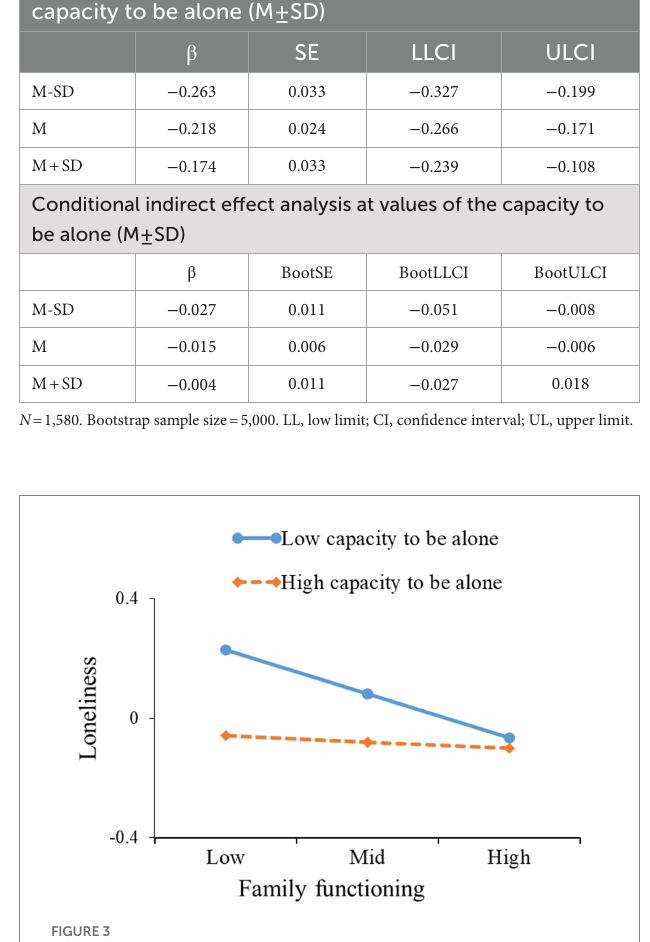
TABLE 4 Conditional effect analysis at values of the self-control variable. Conditional direct effect analysis at values of the capacity to be alone (M ± SD)